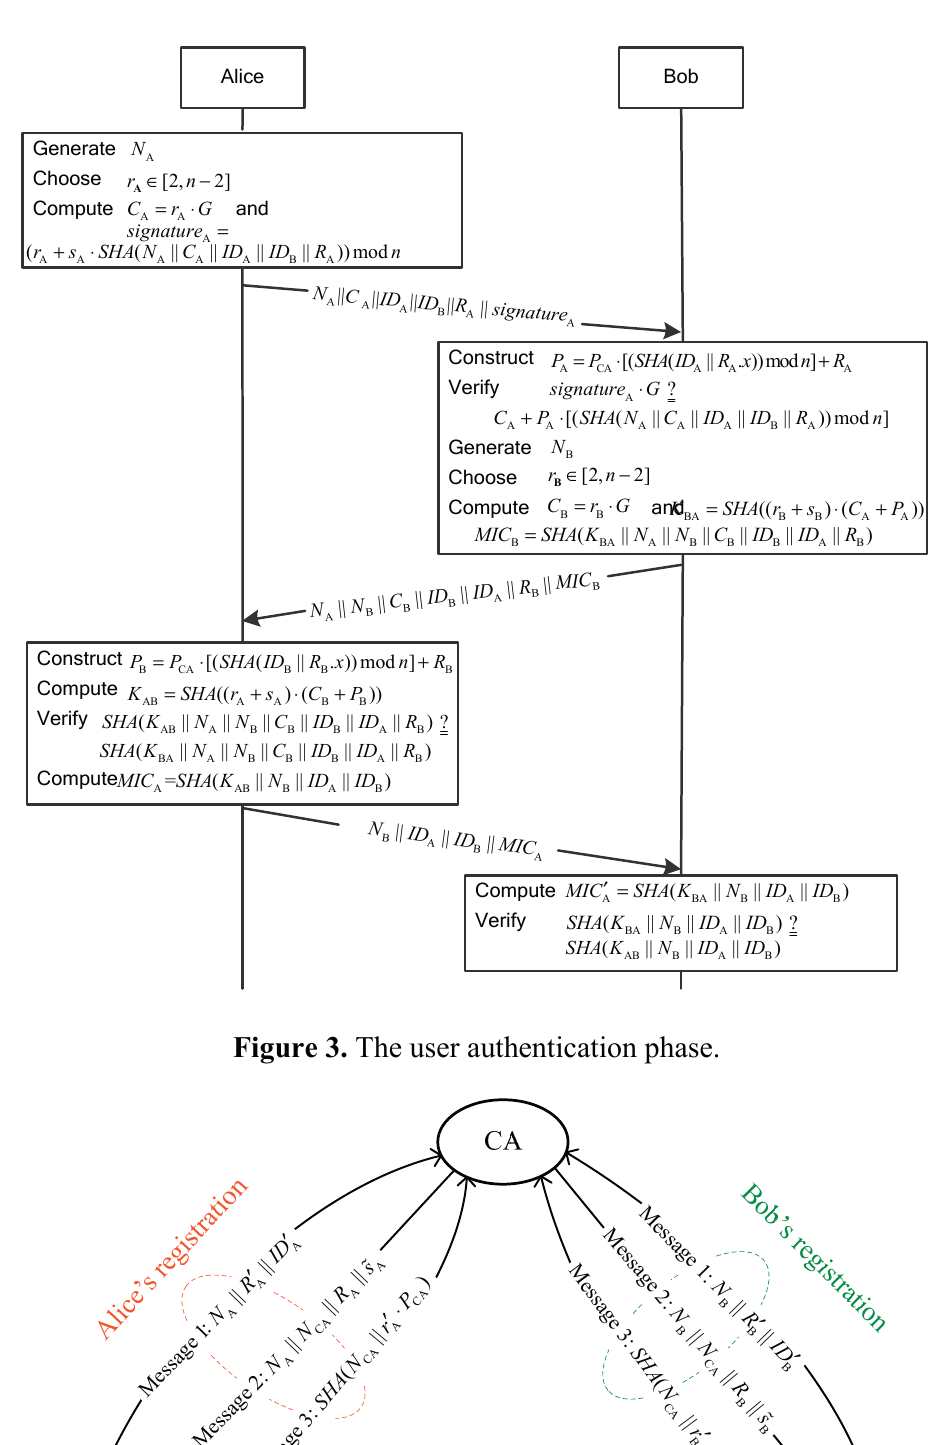
Figure 4. The proposed user authentication